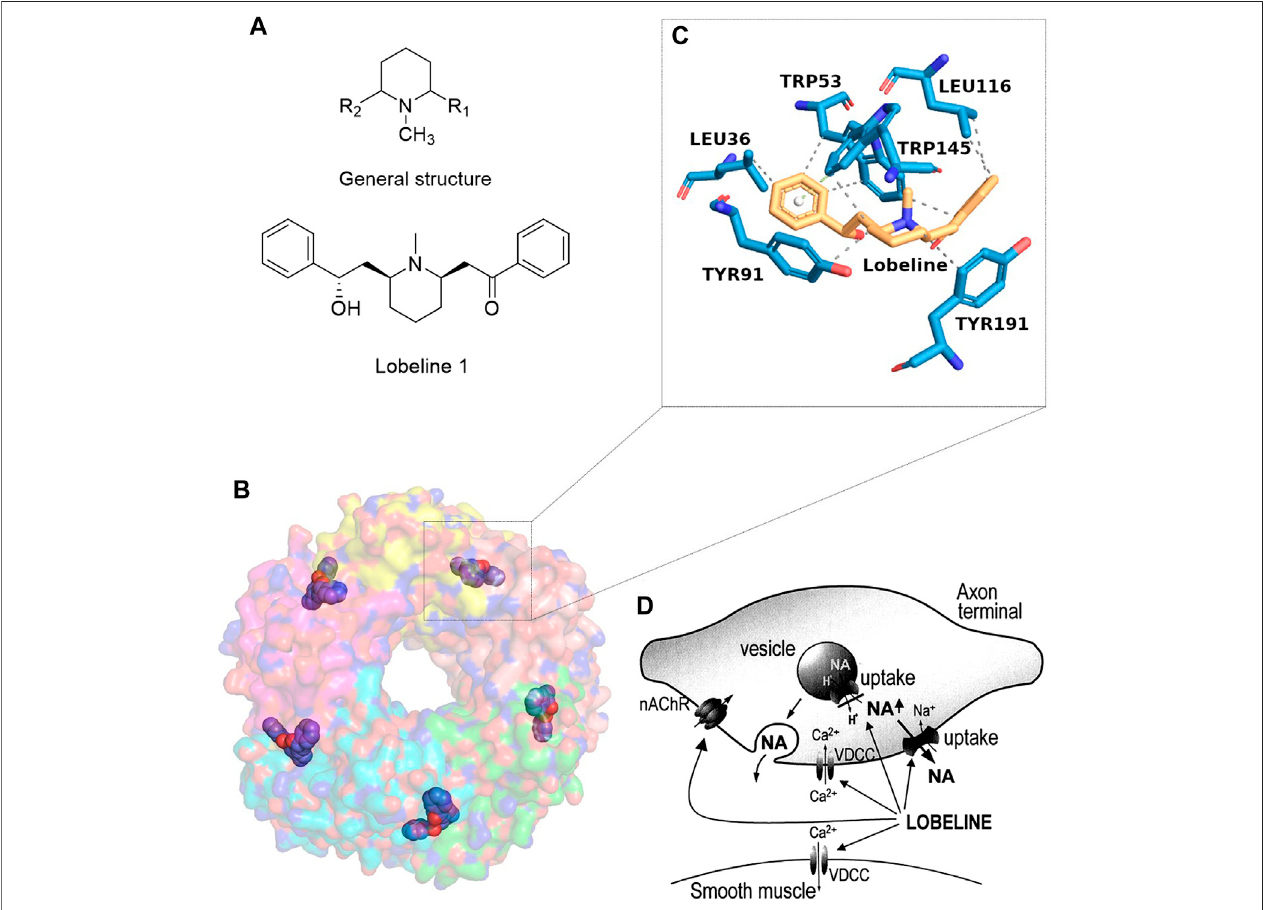
FIGURE1| Structureandmolecularmechanismoflobeline. (A) Chemicalstructure. (B,C) Molecularinteractionoflobelineboundtothehuman α 7-nAChR(Spurny et al., 2015). (D) A schematic diagram of the multiple cellular mechanisms of lobeline on the release of norepinephrine taken from the reference (Sántha et al., 2000).